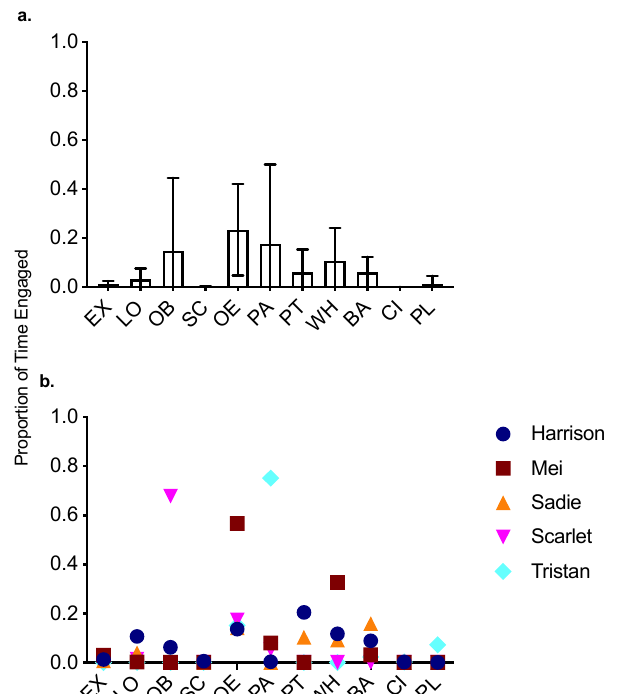
Figure 1. ( a ). Mean and SD of the proportion of time dogs engaged in various behavioral categories during Baseline. ( b ) . Individual dogs’ proportion of time engaged in various behavioral categories.